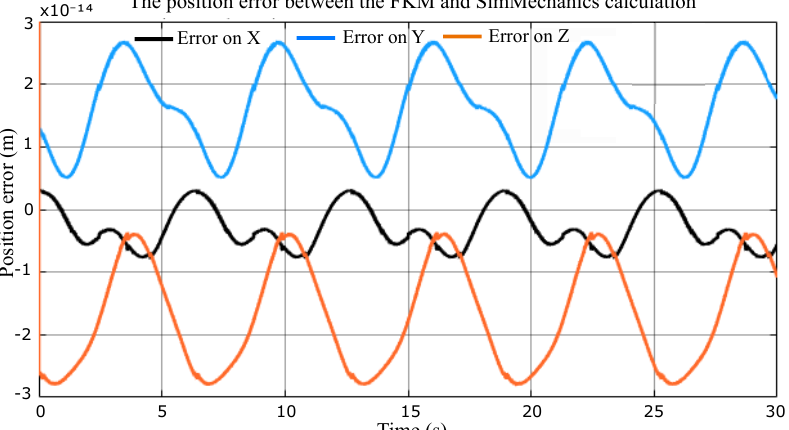
Figure 14. Comparison between the analytic FKM model and the numerical model exported from SolidWorks to